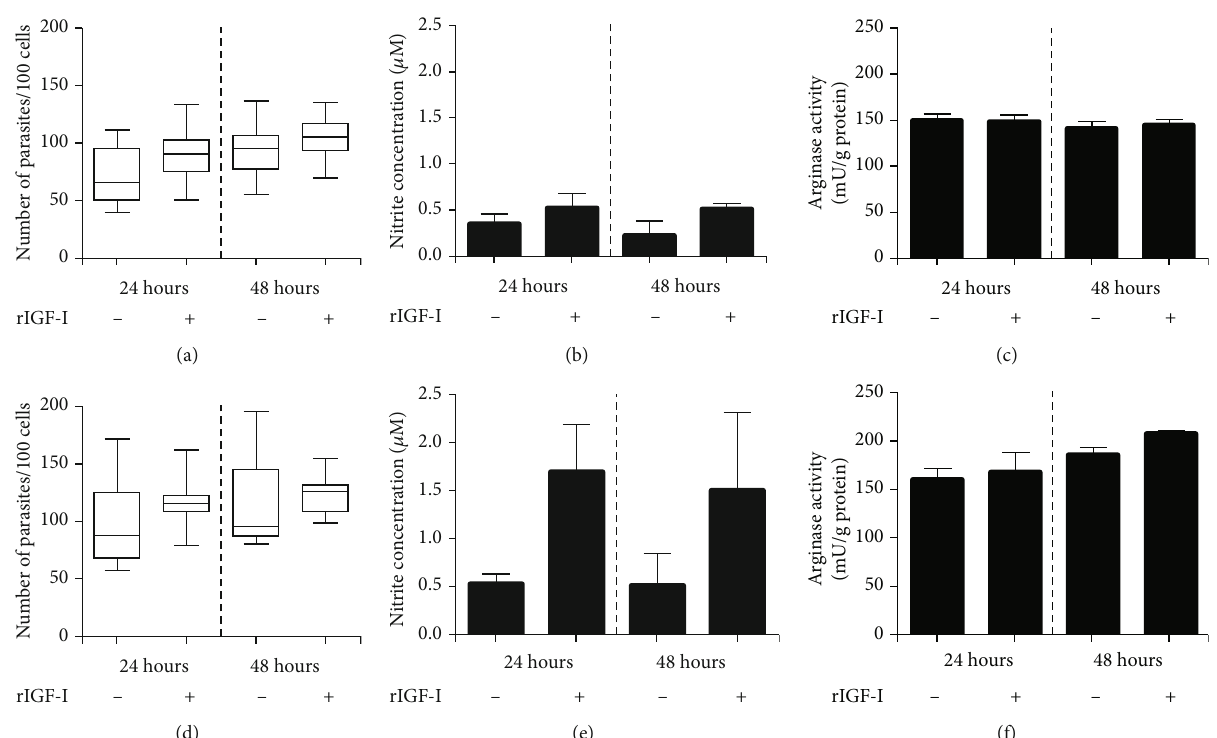
Figure 3: Parasitism and nitric oxide production in L. infantum -infected cells upon extrinsic IGF-I stimulus. THP-1 cells (a – c) or BALB/c mouse bone marrow-derived macrophages (d – f) were infected with L. infantum promastigotes and stimulated with recombinant IGF-I (rIGF-I, 50 ng/mL; R&D Systems, USA) for 24 and 48 hours. One representative experiment from three independent assays is shown. THP-1 cells were di ff erentiated into macrophages with 20ng/mL phorbol 12-myristate 13-acetate (PMA; Sigma-Aldrich, USA) for 24 hours. Then, the cells were washed and allowed to rest in a fresh medium for 48 hours before infection with L. infantum promastigotes. The parasitism (median number of parasites per 100 cells), nitric oxide production (Griess Reagent), and arginase activity (urea production) were determined after 24 and 48 hours of